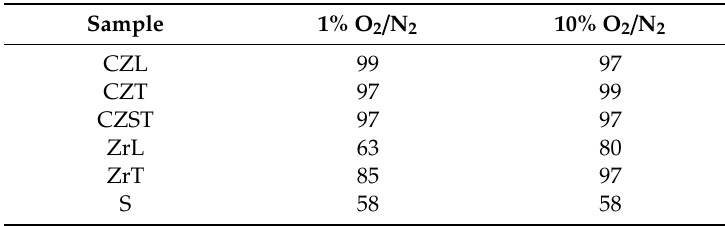
Table 2. CO 2 selectivity from TPO